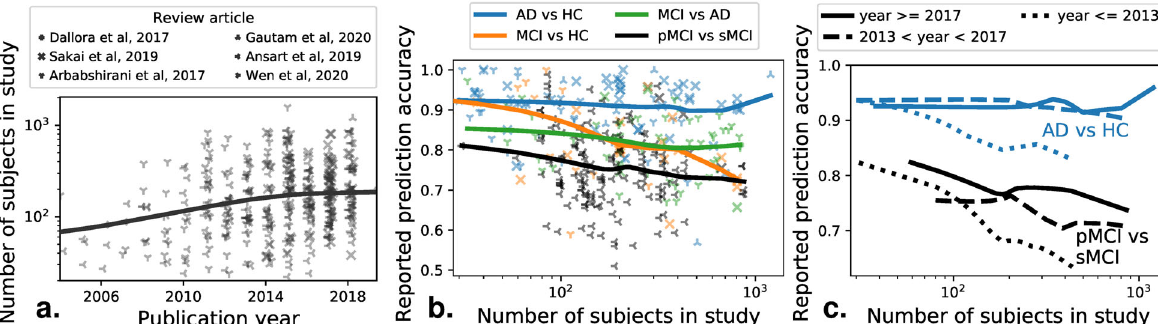
Fig. 1 Larger brain-imaging datasets are not enough for better machine-learning diagnosis of Alzheimer ’ s. A meta-analysis across 6 review papers, covering more than 500 individual publications. The machine-learning problem is typically formulated as distinguishing various related clinical conditions, Alzheimer ’ s Disease (AD), Healthy Control (HC), and Mild Cognitive Impairment, which can signal prodromal Alzheimer ’ s . Distinguishing progressive mild cognitive impairment (pMCI) from stable mild cognitive impairment (sMCI) is the most relevant machine-learning task from the clinical standpoint. a Reported sample size as a function of the publication year of a study. b Reported prediction accuracy as a function of the number of subjects in a study. c Same plot distinguishing studies published in different years.